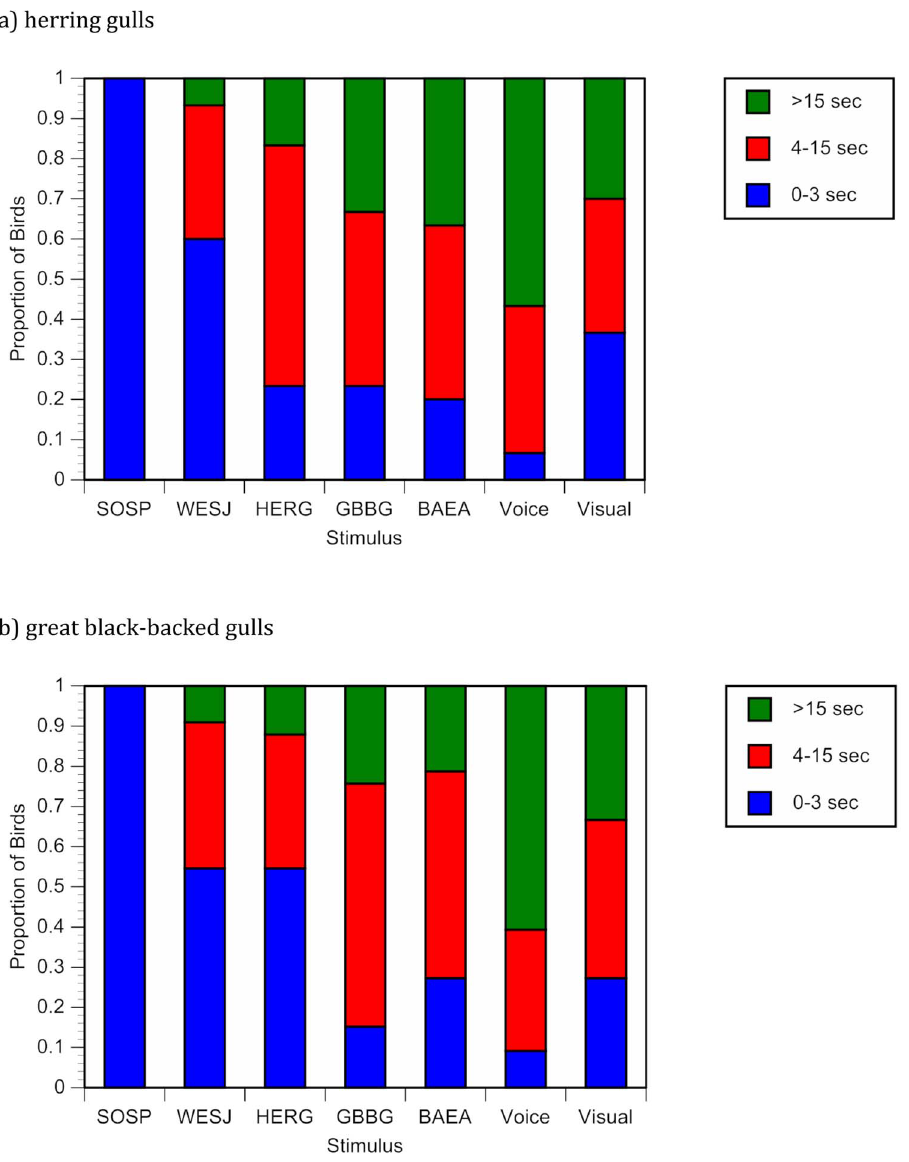
Figure 2. Duration of response to auditory threats. Duration of response by (a) herring gulls and (b) great black-backed gulls to various auditory stimuli and a physical approach by a human. Because the majority of responses fell in lower time intervals, latencies above 15 sec have been binned to aid visualization. SOSP = song sparrow, WESJ = western scrub-jay, HERG = herring gull, GBBG = great black-backed gull, BAEA = bald eagle. black-backed gull, the inverse relationship was weaker. Great black-backed gulls reacted more strongly to great black-backed gull alarm calls than to herring gull alarm calls ( P , 0.001).